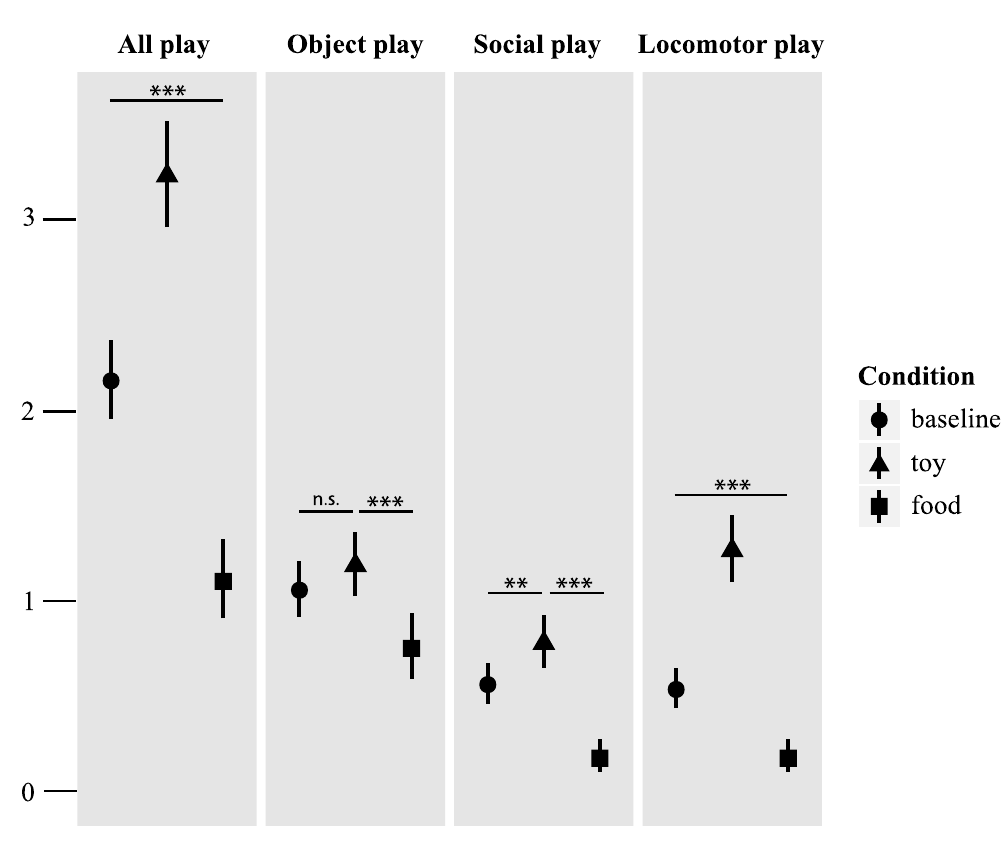
Figure 3. The differences in play behaviors initiated per individual per ten minutes under the different